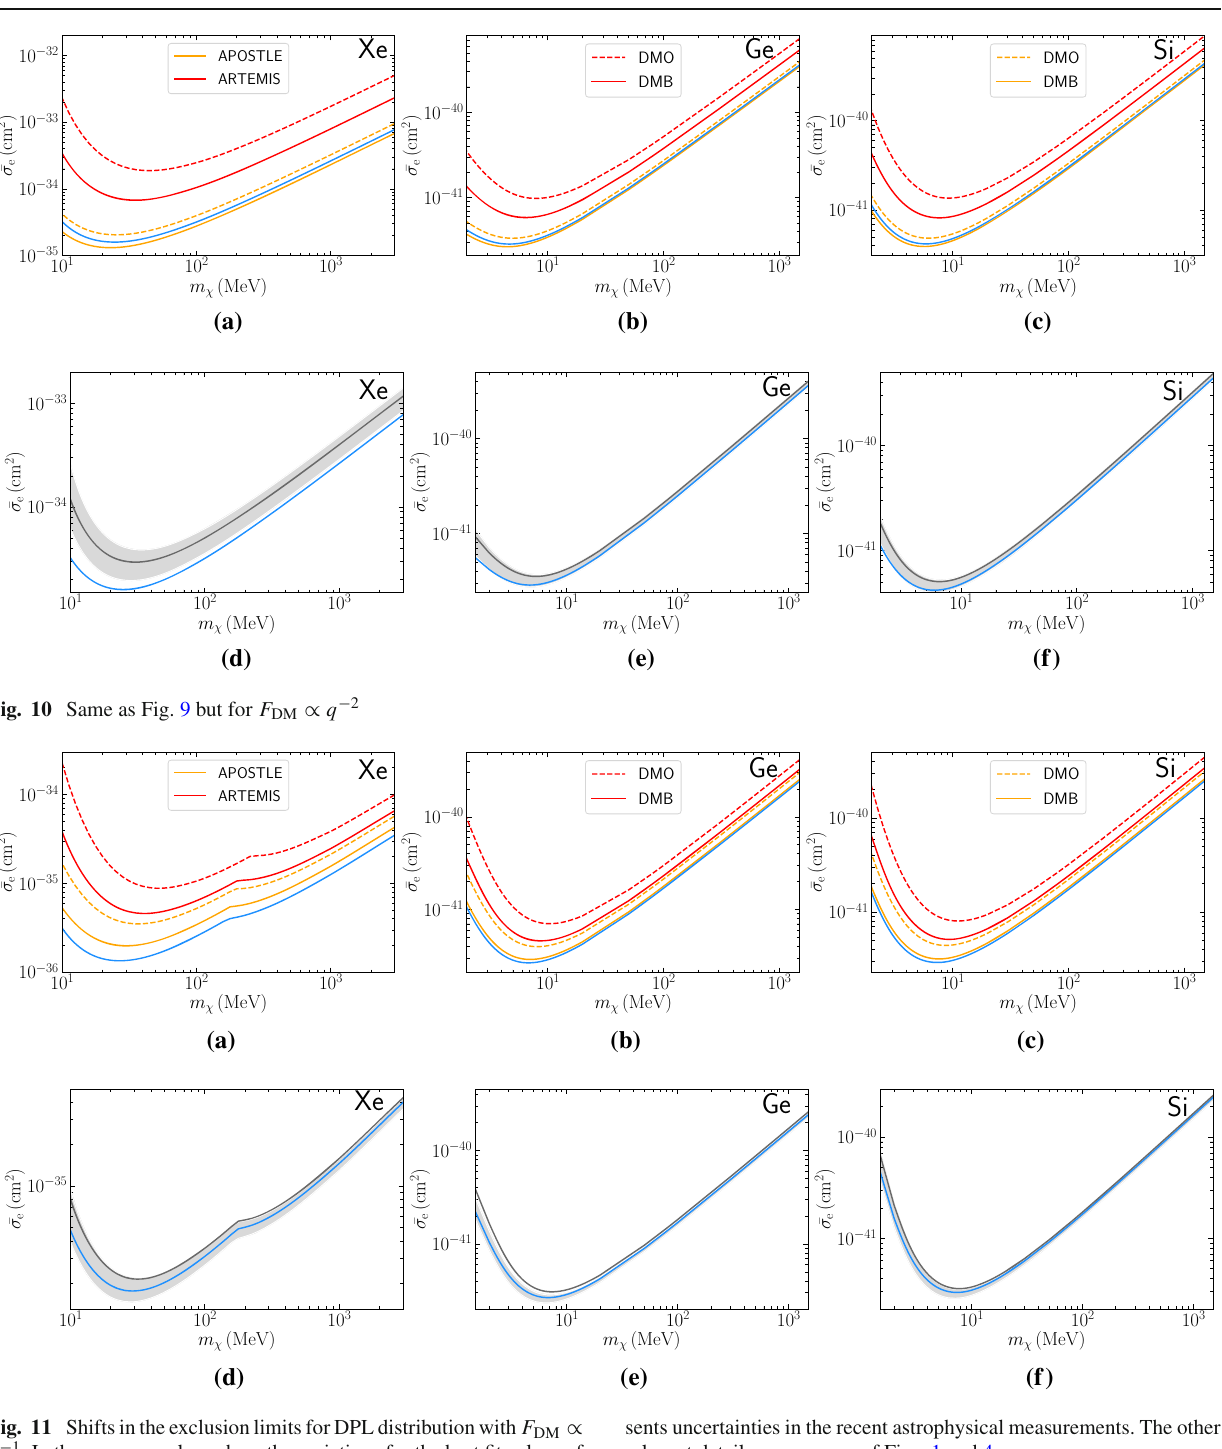
sents uncertainties in the recent astrophysical measurements. The other relevant details are same as of Figs. 1 and